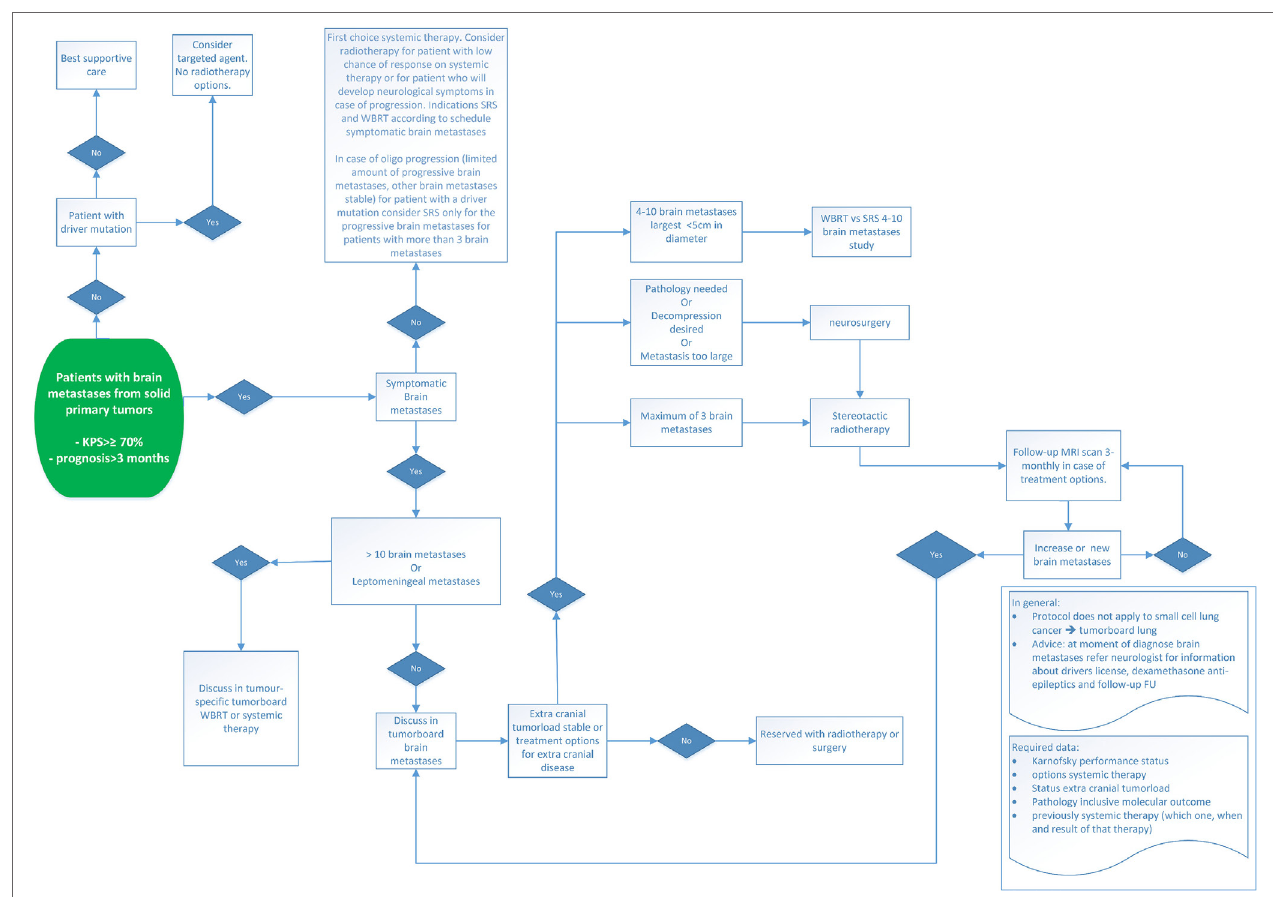
FiGURe 1 | Treatment options for BM of NSCLC. Abbreviations: KPS, Karnofsky performance status; WBRT, whole-brain radiotherapy; SRS, stereotactic radiosurgery; BM, brain metastases; MRI, magnetic resonance imaging; NSCLC, non-small cell lung